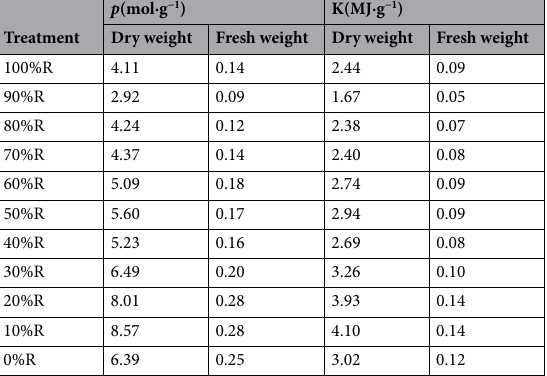
Table 2. Photons and electric power consumption for producing per unit weight of lettuce harvested at 49 DAS. p : photons consumed for producing per gram of lettuce in a unit of planting area; k:electric energy consumed for producing per gram of lettuce in a unit of planting area.